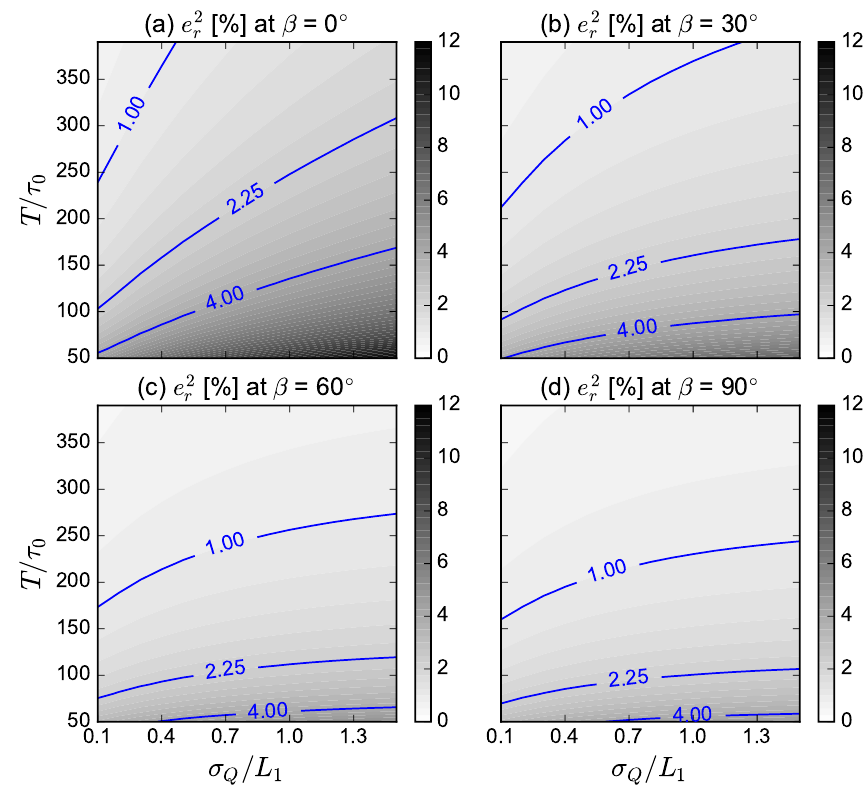
(cid:16) (cid:17) e 2 r Figure 13. Contours of the relative variance of random errors of radial velocity variance from lidar measurements estimated with the isotropic turbulence model (Pope, 2000) and the von Kármán spectra (Burton et al., 2011) as a function of the sampling duration ( T ) normalized by the integral timescale ( τ 0 ) and the volumetric averaging size ( σ Q ) normalized by the streamwise integral length scale ( L 1 ) for four different β values, where β is the angle between the LOS and the wind direction. The other input parameters include the sampling interval δt = 0 . 5 τ 0 , the elevation angle φ = 10 ◦ , and the mean wind speed U 1 = 8ms − 1